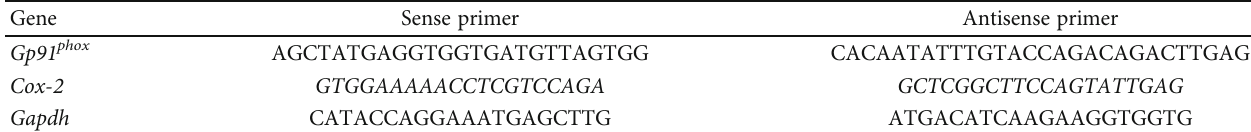
Table 1: Primer sequences.